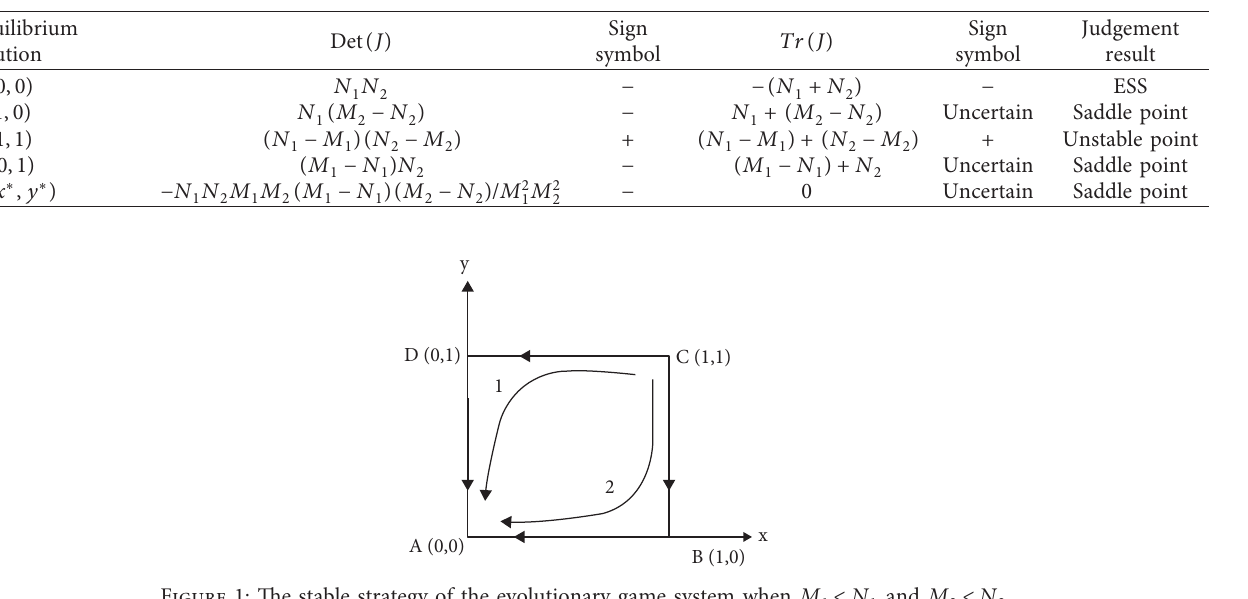
Table 3: Stability analysis of equilibrium points when M